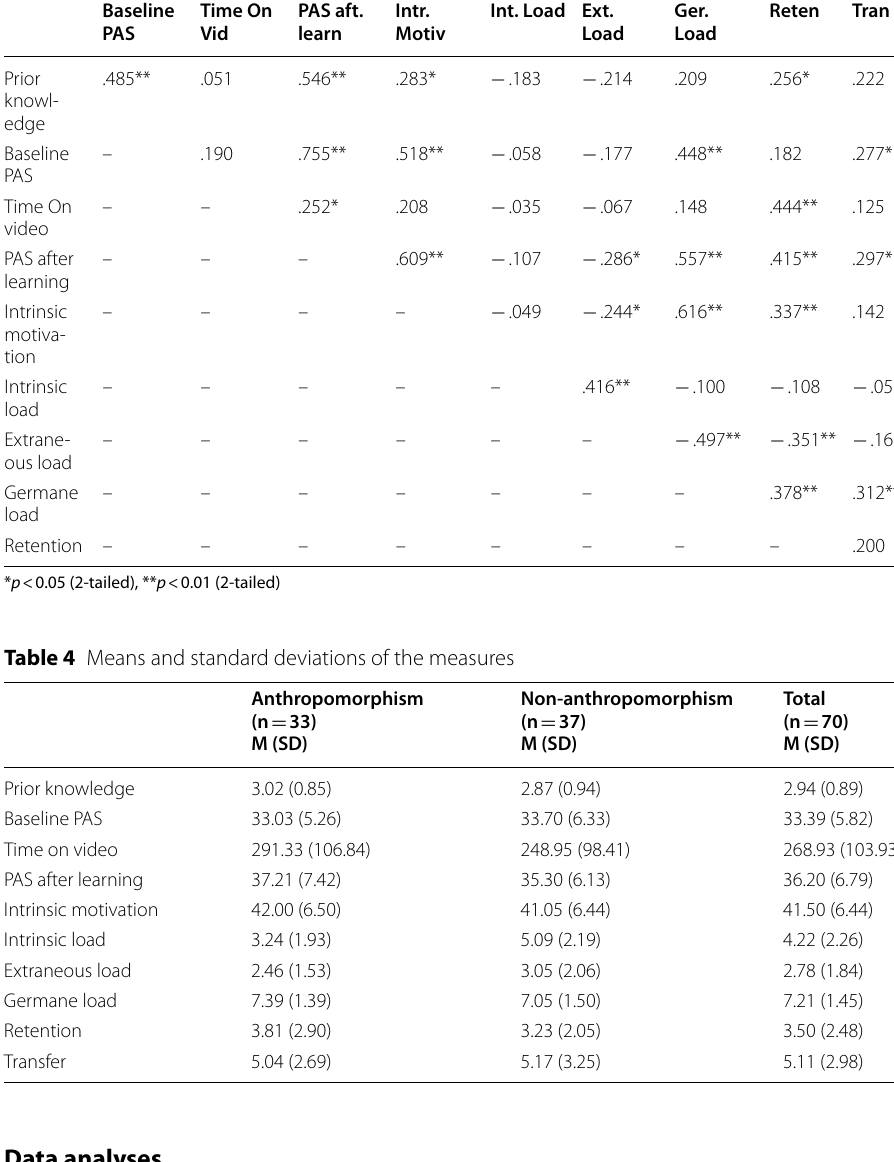
Table 3 Bivariate correlations between the measures